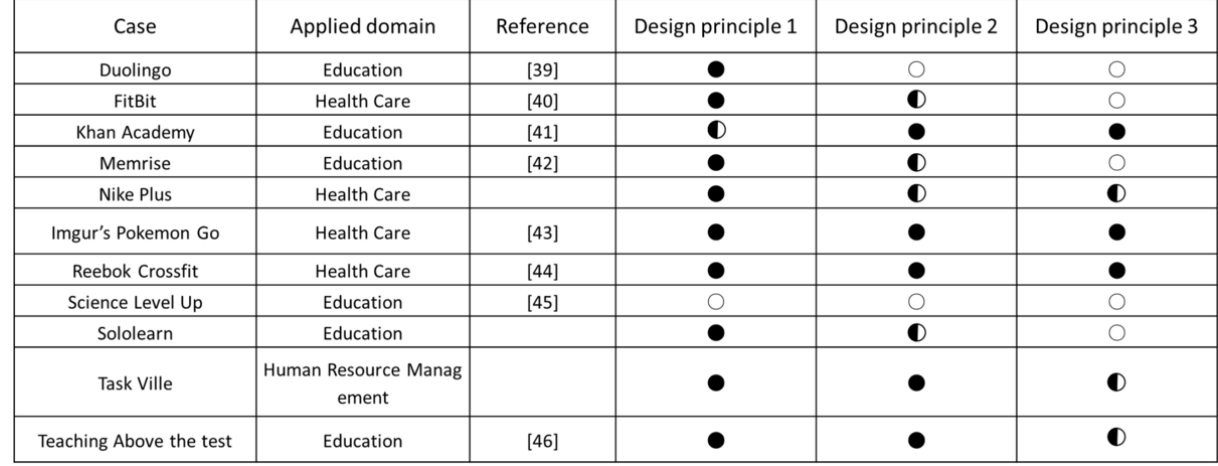
Duolingo, Khan Academy, Memrise, Science Level Up, and Sololearn are web-based learning platforms. Fitbit, NikePlus, Imgur’s Pokemon Go, and Reebok Crossfit’s “The Open” Challenge are cases related to health care. Pokemon Go is